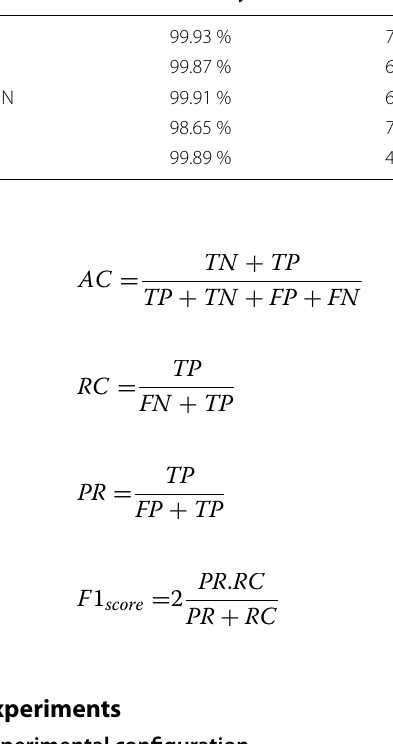
Table 3 Classification results for v 2